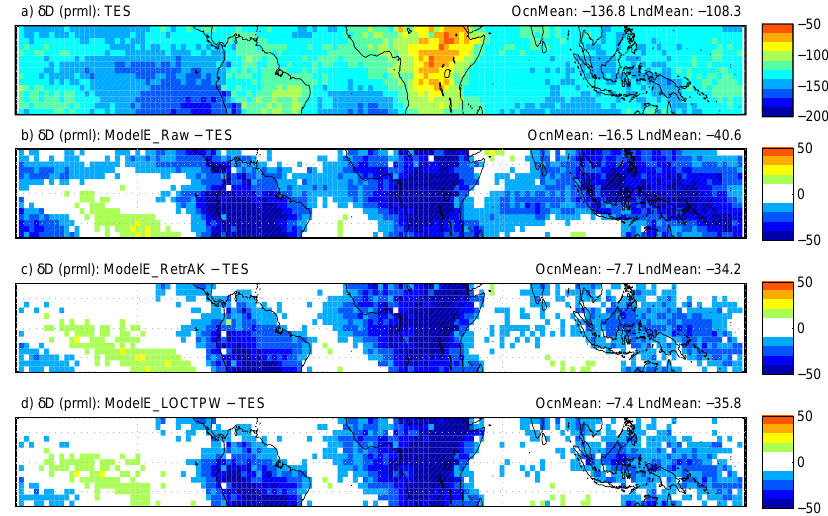
Fig. 18. (a) Retrieved TES δ D (‰). Difference between ModelE and TES for: (b) raw model δ D (c) model δ D after applying the retrieval- based operator (d) model δ D after applying the LOCTPW categorical